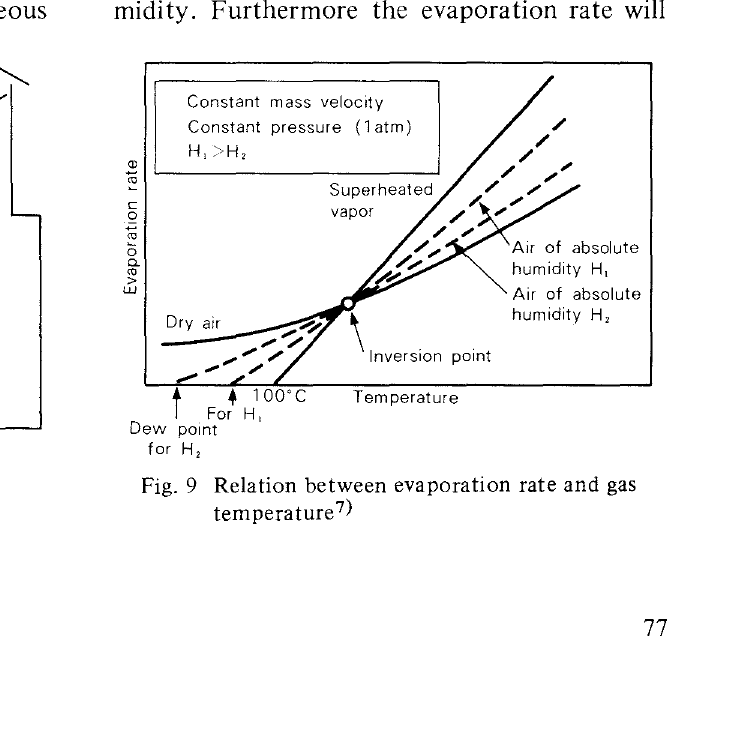
Fig. 9 Relation between evaporation rate and gas temperature